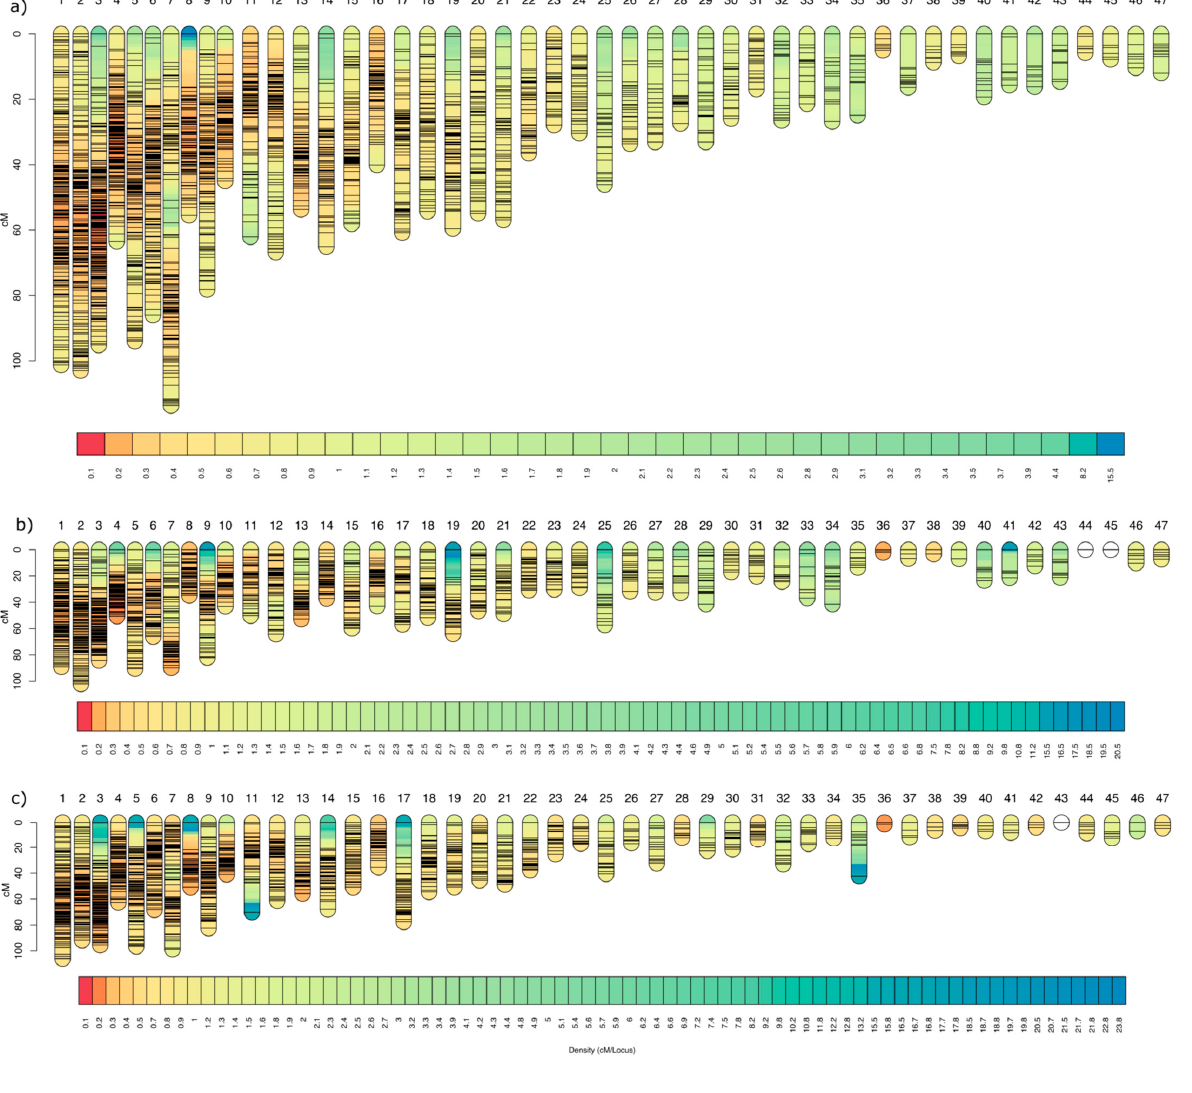
Figure 1 . Genetic linkage map generated using LEPMAP3 for H. maculosa ( a ) sex-averaged map ( b ) maternal map ( c ) paternal map. Marker density (cM/Locus) is visualised in a scale from red (high) to blue (low). Table 1. Statistical summary of Hapalochlaena maculosa sex averaged, paternal and maternal linkage maps. Linkage groups (LG) Table 2. Genome coverage estimation of sex average, maternal and paternal Hapalochlaena maculosa linkage maps. Genome length estimation method 1 (Ge1) and 2